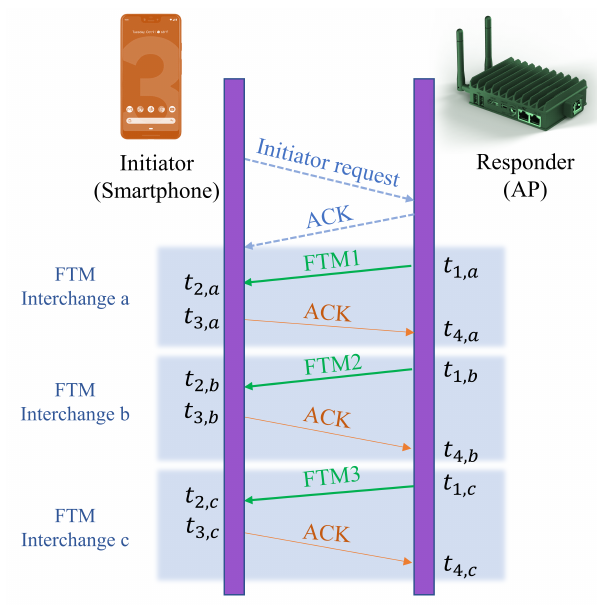
Figure 1. WiFi Fine Timing Measurement (FTM) protocol illustrating one burst with 3 FTM inter-